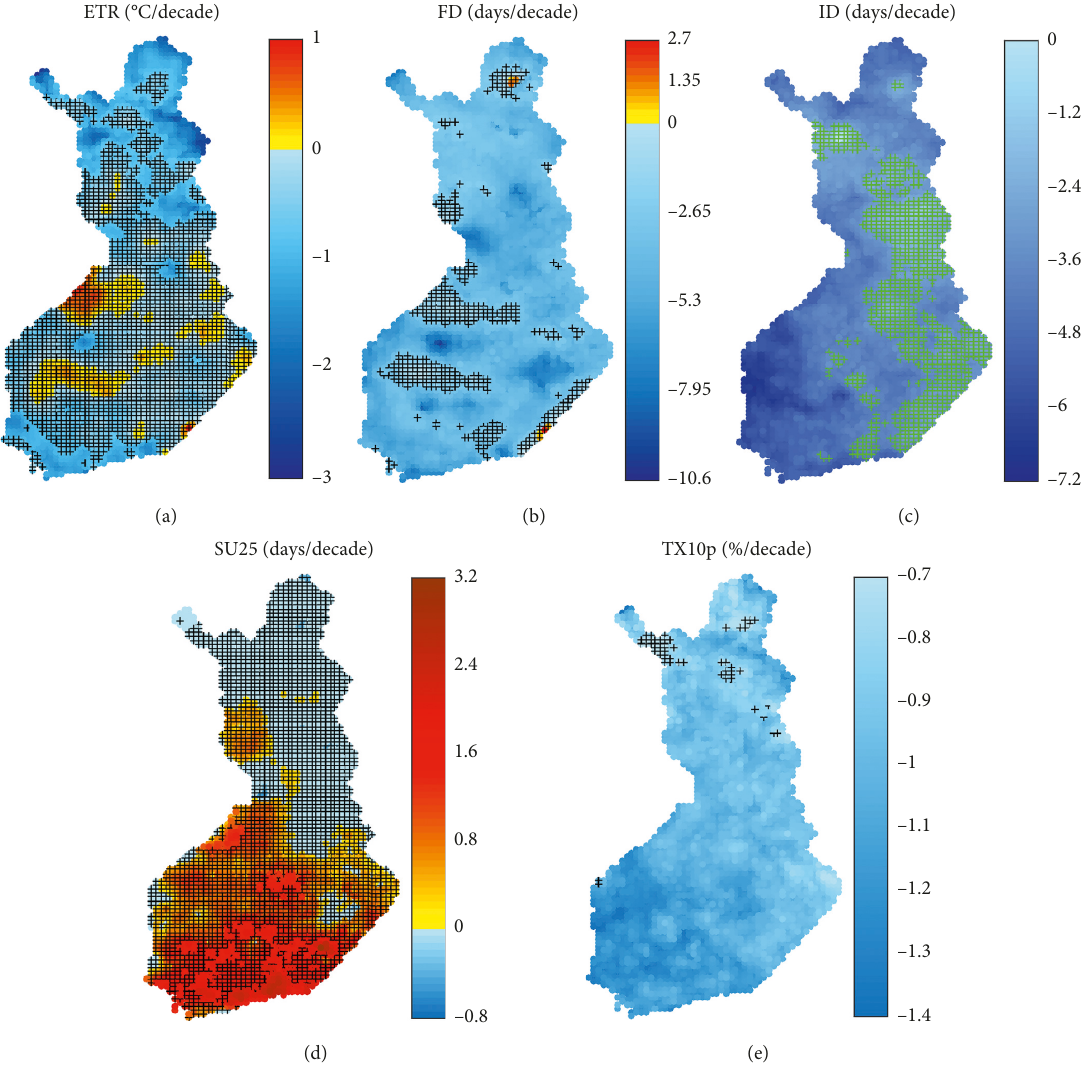
Figure 7: Spatial distribution maps of trends (/decade) in (a) ETR, (b) FD, (c) ID, (d) SU25, and (e) TX10p in Finland during 1961–2011. The stippling indicates areas where the trends are statistically insignificant ( p